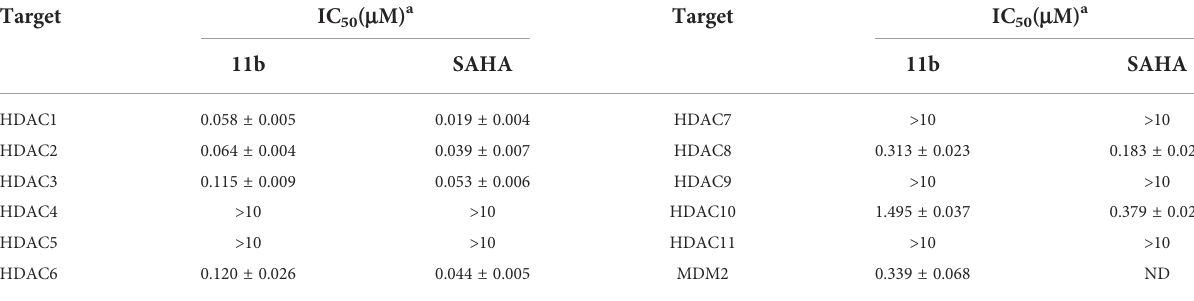
TABLE 6 IC 50 values of compound 11b against HDAC